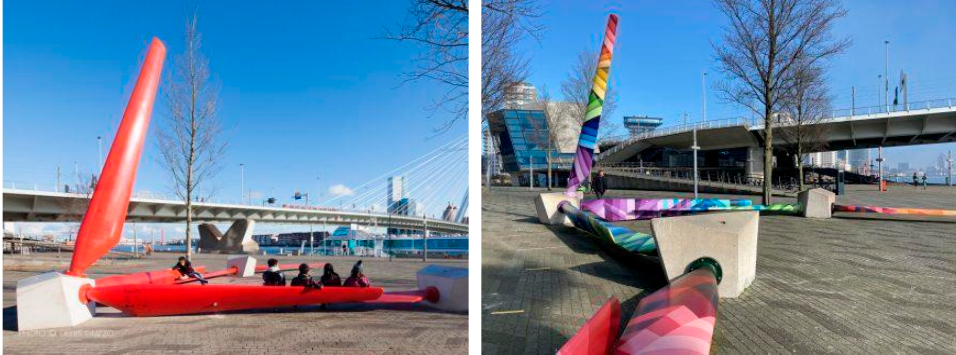
Figure A6. Wikado playground [48].